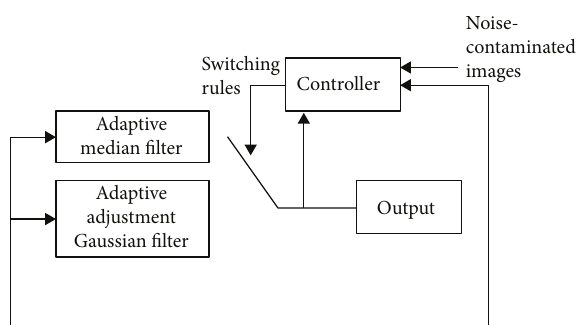
Figure 2: The schematic diagram of the proposed fi lter switching